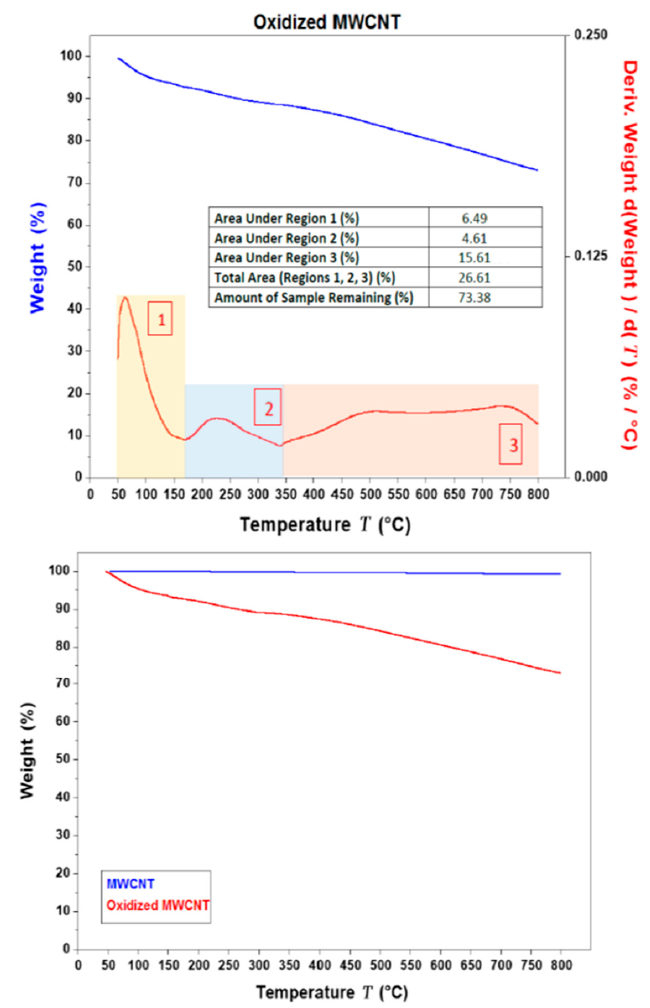
Figure 3. ( a ) Thermo-gravimetric analysis (TGA) (in blue) and derivative thermo-gravimetric analysis (DTGA) (in red) thermograms for OMWCNT. The area under the different segments of the graph are quantified in the insert. ( b ) Overlay of the TGA thermograms for both MWCNT (in blue) and OMWCNT (in red).